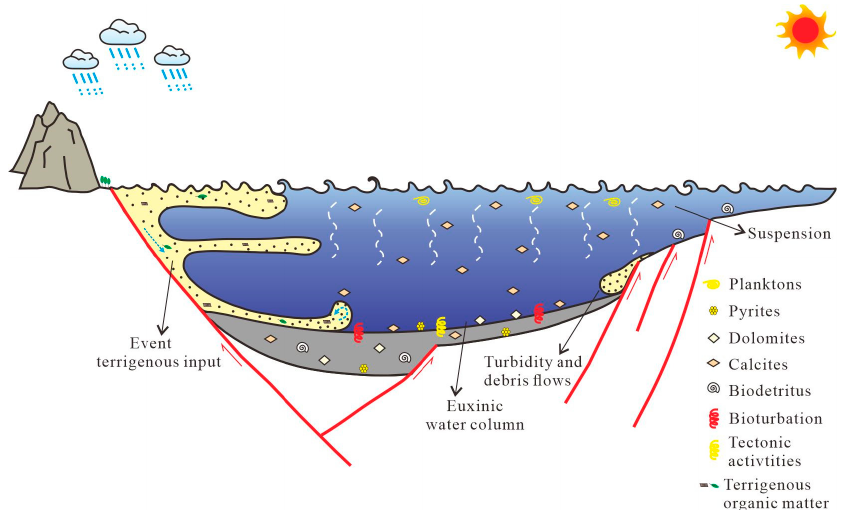
Figure 11. Generalized deposition model showing depositional processes for the fine-grained sedi- mentary rocks in Es4s in Dongying Depression.